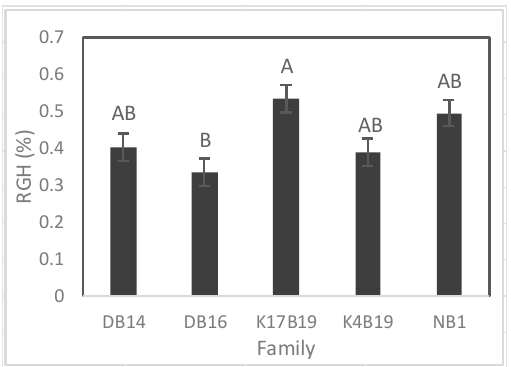
Figure 10. Variation of relative growth rate of height (RGH) between Senegalia senegal families) and during drought stress. Different letters on bars mean significant differences among families at p < 0.05.